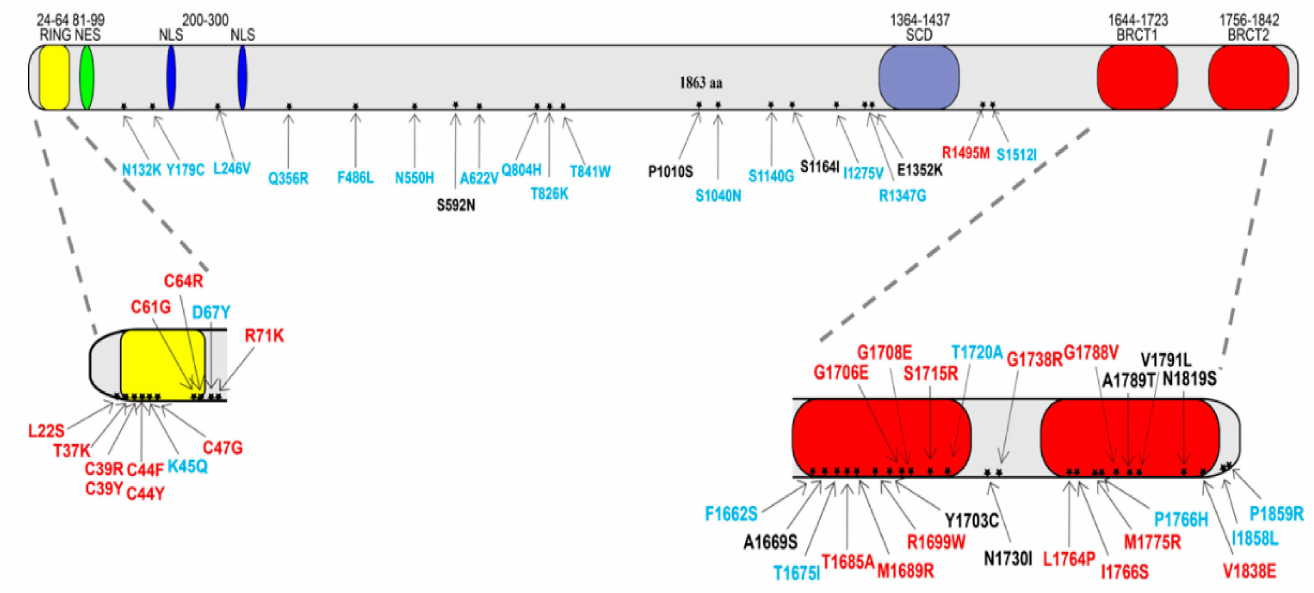
Figure 1. BRCA1 variant localization. BRCA1 protein structure, domains, and variant localization. BRCA1 is a protein that is composed of 1863 amino-acids. Amino-acid length is reported for any domain. RING domain, nuclear entry site, and localization signal are shown (NES, NLS); Serine cluster (SCD) and BRCT domain are also depicted. The variants, reported as amino-acid substitution, are distributed throughout all BRCA1 coding sequences; Pathogenic are shown in red, benign in blue, and VUS in